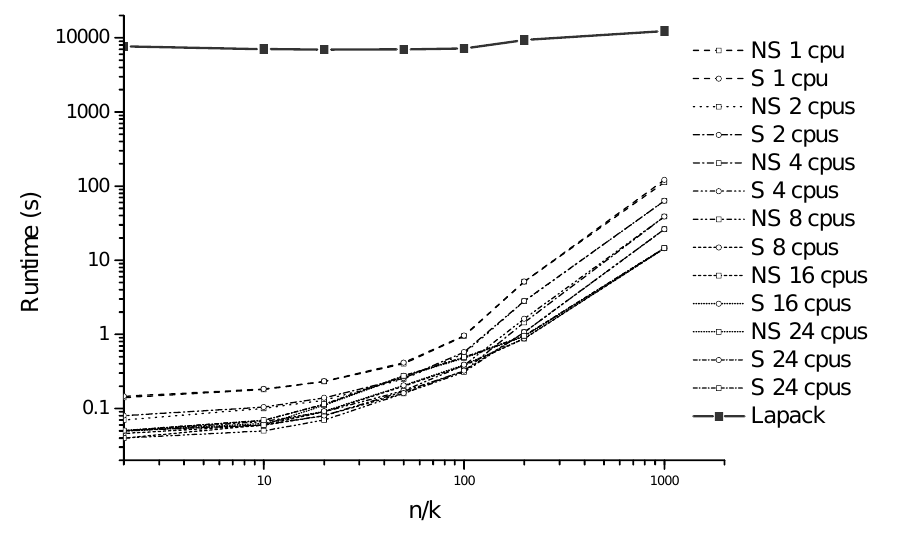
Figure 2. Average runtime of our proposed algorithm (marked S in the legend), the algorithm of [30] (marked NS in the legend) and Lapack for n = 10,000 and multiple values of k and multiple numbers of